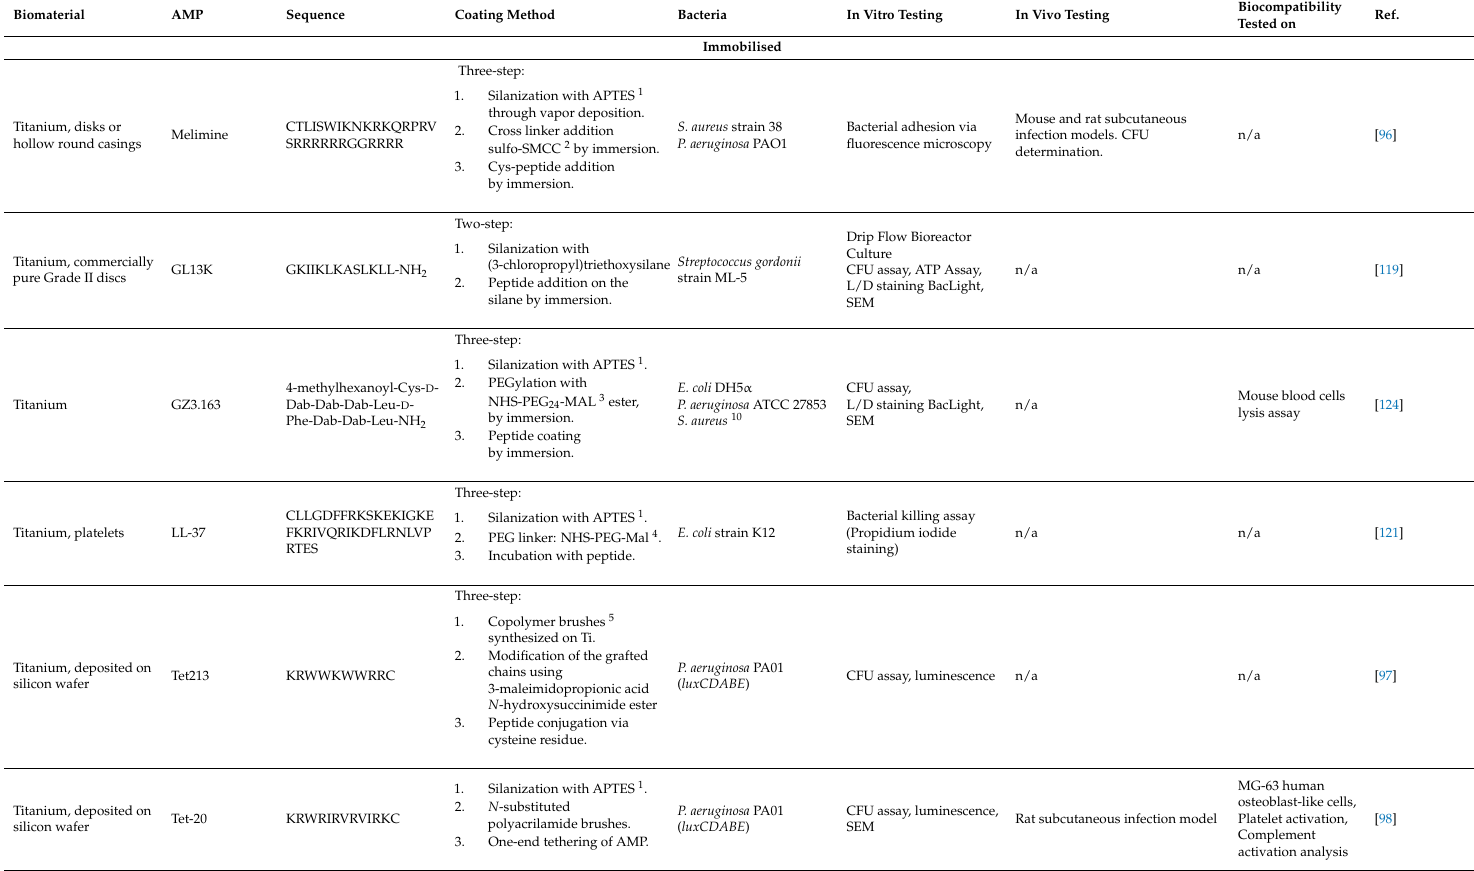
Table 4. Examples of AMPs immobilized on titanium with different